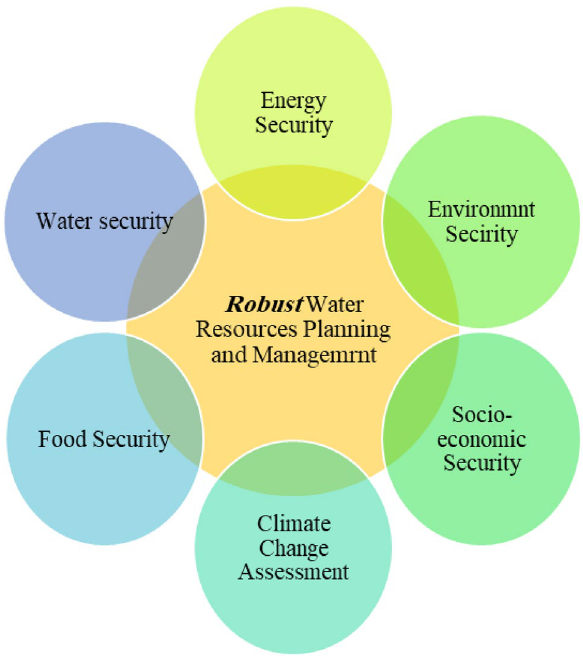
Figure 1. Basic components of the robust decision-making paradigm for water resources planning and